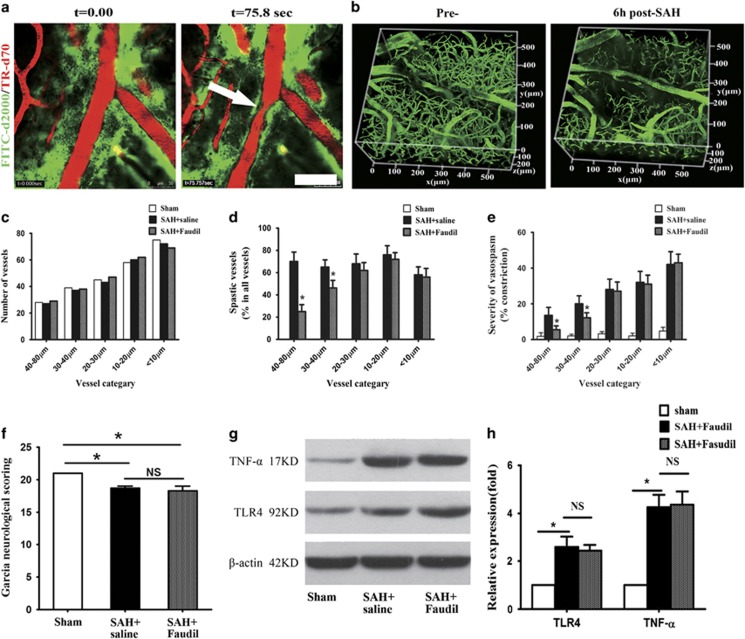
Prevention of vasospasm with Fasudil fails to alleviate neurologic deficits and neuroinflammation after SAH. (a) Representative images showing the vasospasm induced by the blood in the PVS. (b) Representative images showing the microvaspasm at 6 h after SAH. (c) The number of vessels was analyzed in each vessel category (5 mice in each experimental group). (d) Fasudil treatment was effective in reducing the incidence of large-artery (diameter of 40–80 μm) vasospasm, but failed to the arterioles diameter less than 30 μm. (e) Fasudil treatment was effective in reducing the severity of large-artery (diameter of 40–80 μm) vasospasm, but failed to the arterioles diameter less than 30 μm. (f) Fasudil treatment did not improve neurologic deficits on day 7 after SAH (n=5, *P<0.05; NS, P>0.05). (g and h) Western-blot analyses demonstrated that Fasudil treatment did not inhibit he expression of TLR4 and TNF-α after SAH (n=5, *P<0.05; NS, P>0.05). Scale bar: 50 μm